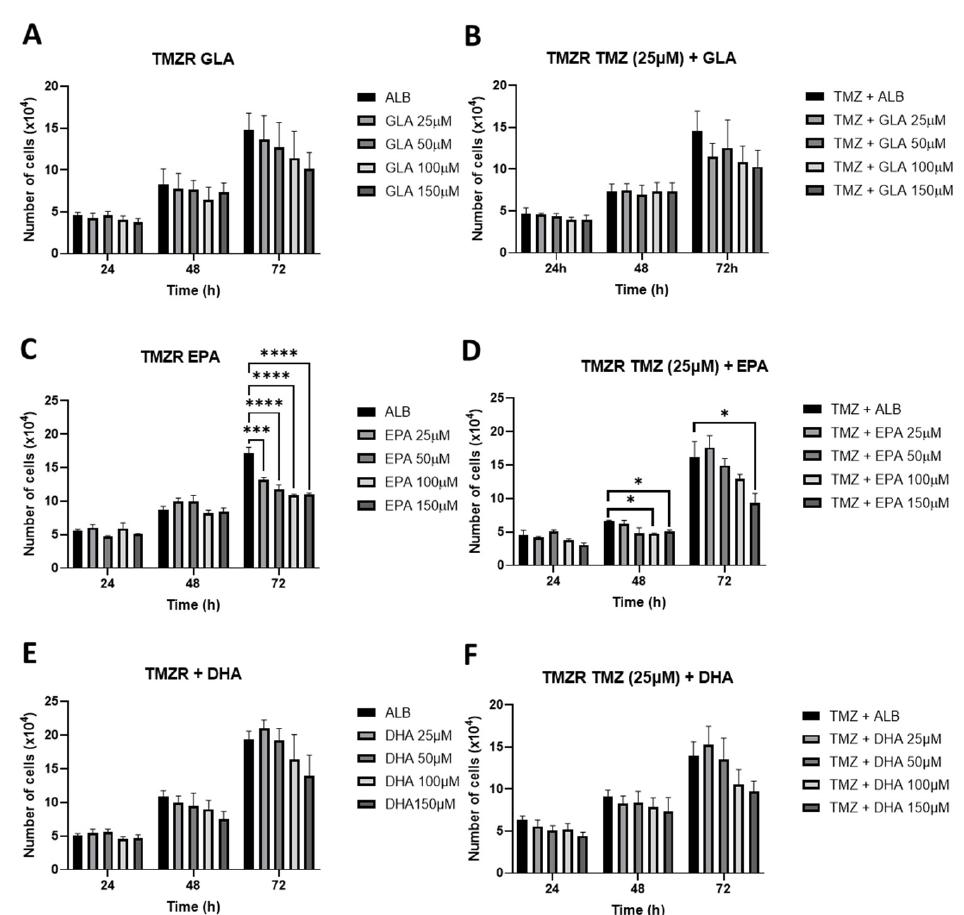
Figure 4. Effects of gamma-linolenic acid (GLA), eicosapentaenoic acid (EPA), and docosahexaenoic acid (DHA) on TMZR cell counts: ( A , C , E ) Graphs show the results after 24, 48, or 72 h of treatment with PUFAs. ( B , D , F ) Graphs show the results after 24, 48, or 72 h of treatment with PUFAs in the presence of TMZ. Data are presented as mean ± SEM, N = 3. Differences were considered significant at p < 0.05. * = p < 0.05; *** = p < 0.001; **** = p < 0.0001.